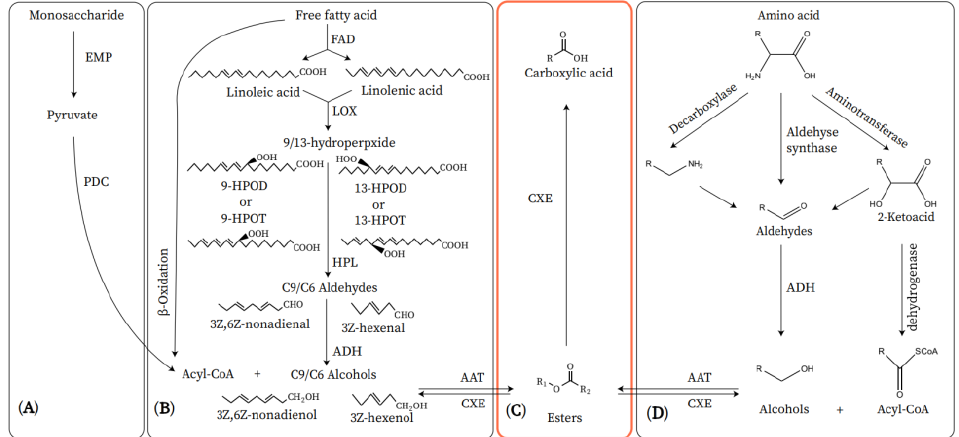
Figure 1. Metabolic pathway of volatile esters in fruit. ( A ) Monosaccharide pathway. ( B ) Fatty acid pathway. ( C ) CXE pathway. ( D ) Amino acid pathway. EMP: Embden-Meyerhof-Parnas; PDC: py- acid pathway. ( C ) CXE pathway. ( D ) Amino acid pathway. EMP: